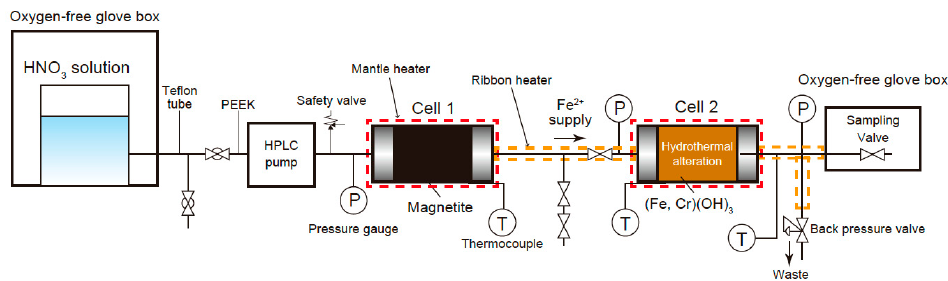
Figure 1. Schematic illustration of the flow-through reactor system used for hydrothermal chromian spinel synthesis (<200 °C, <10 MPa).